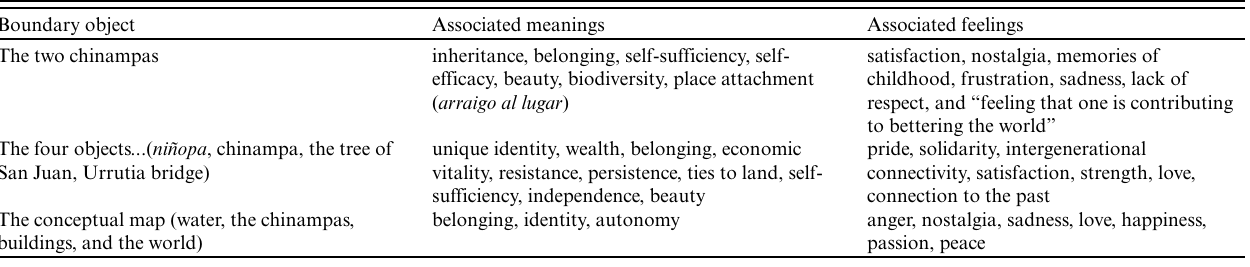
Table 1 . Meanings, emotions, and the associated physical and symbolic